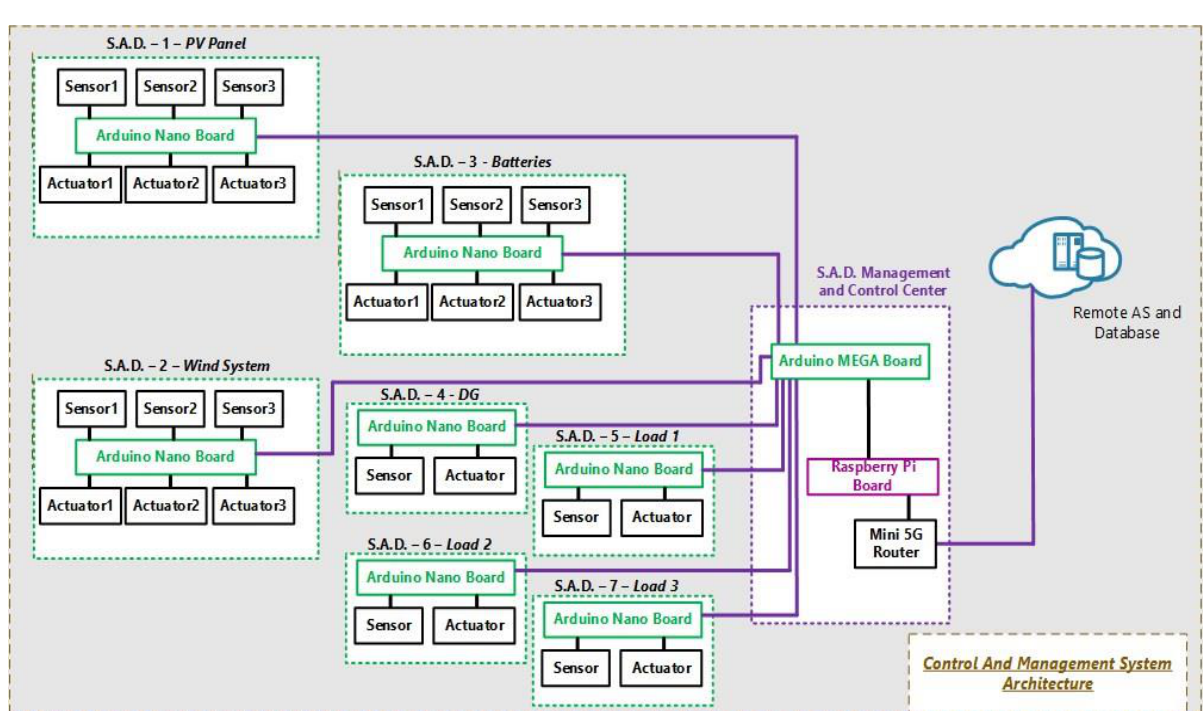
Figure 3 . Control and management system architecture